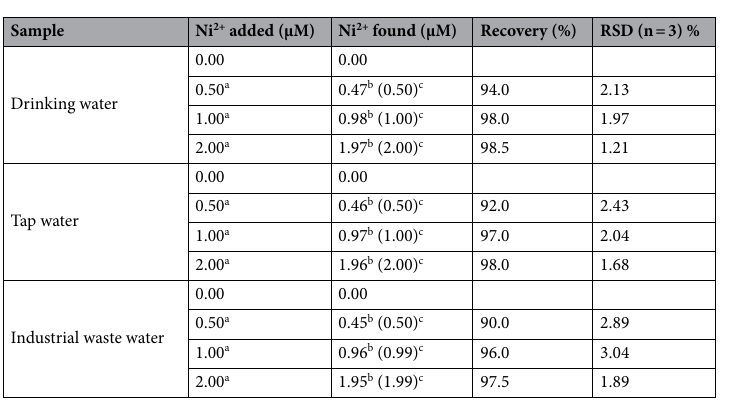
Table 3. Determination of Ni 2+ in water samples. a Artificially spiked concentration of Ni 2+ . b Results obtained by newly synthesized receptor L4. (·) c Results obtained from ICP-OES analysis.